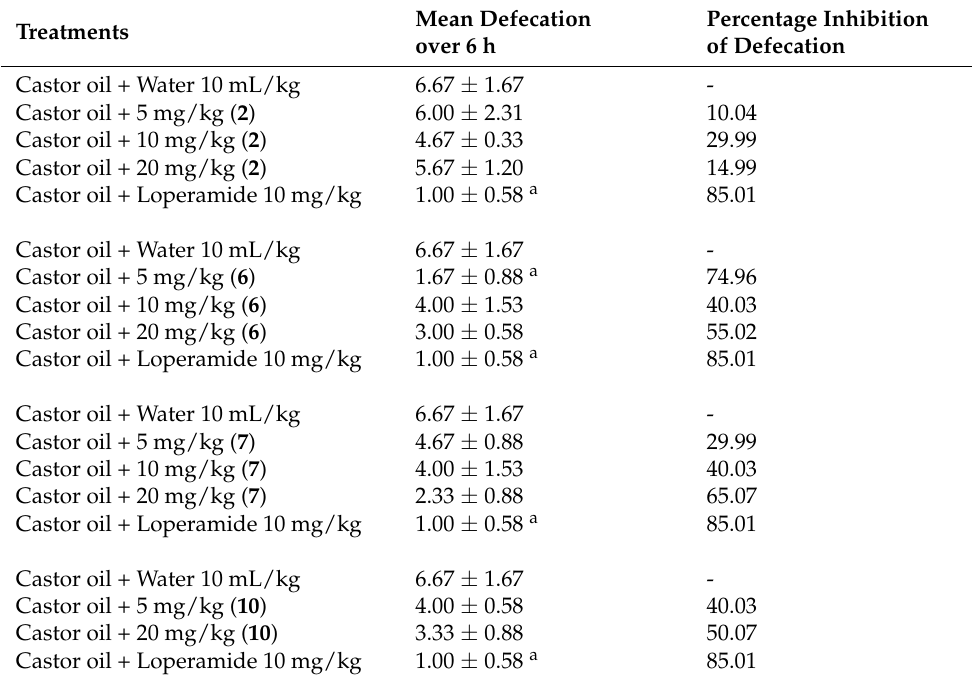
Table 1. Percentage inhibition of defecation of rats treated with compounds 2 , 6 , 7, and 10 .